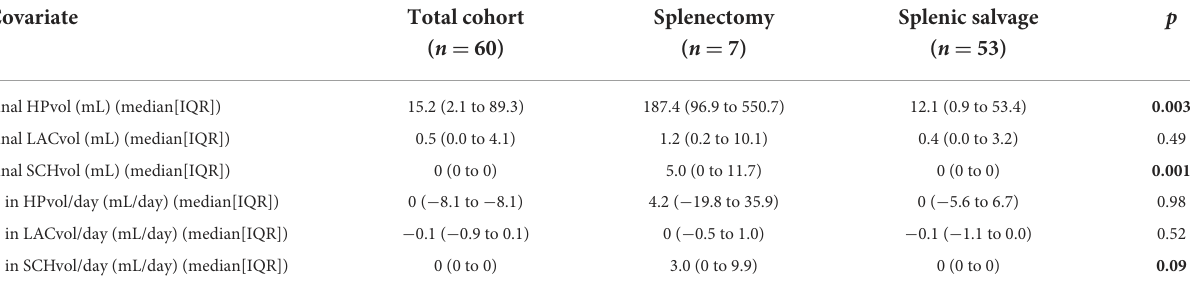
TABLE 2 Volumetric measurements. Covariate